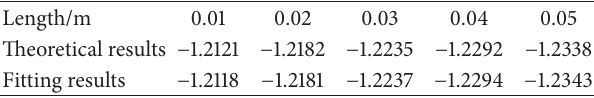
Table 1: Theoretical and fitting results of 𝜇(𝑥) × 10 −5 .